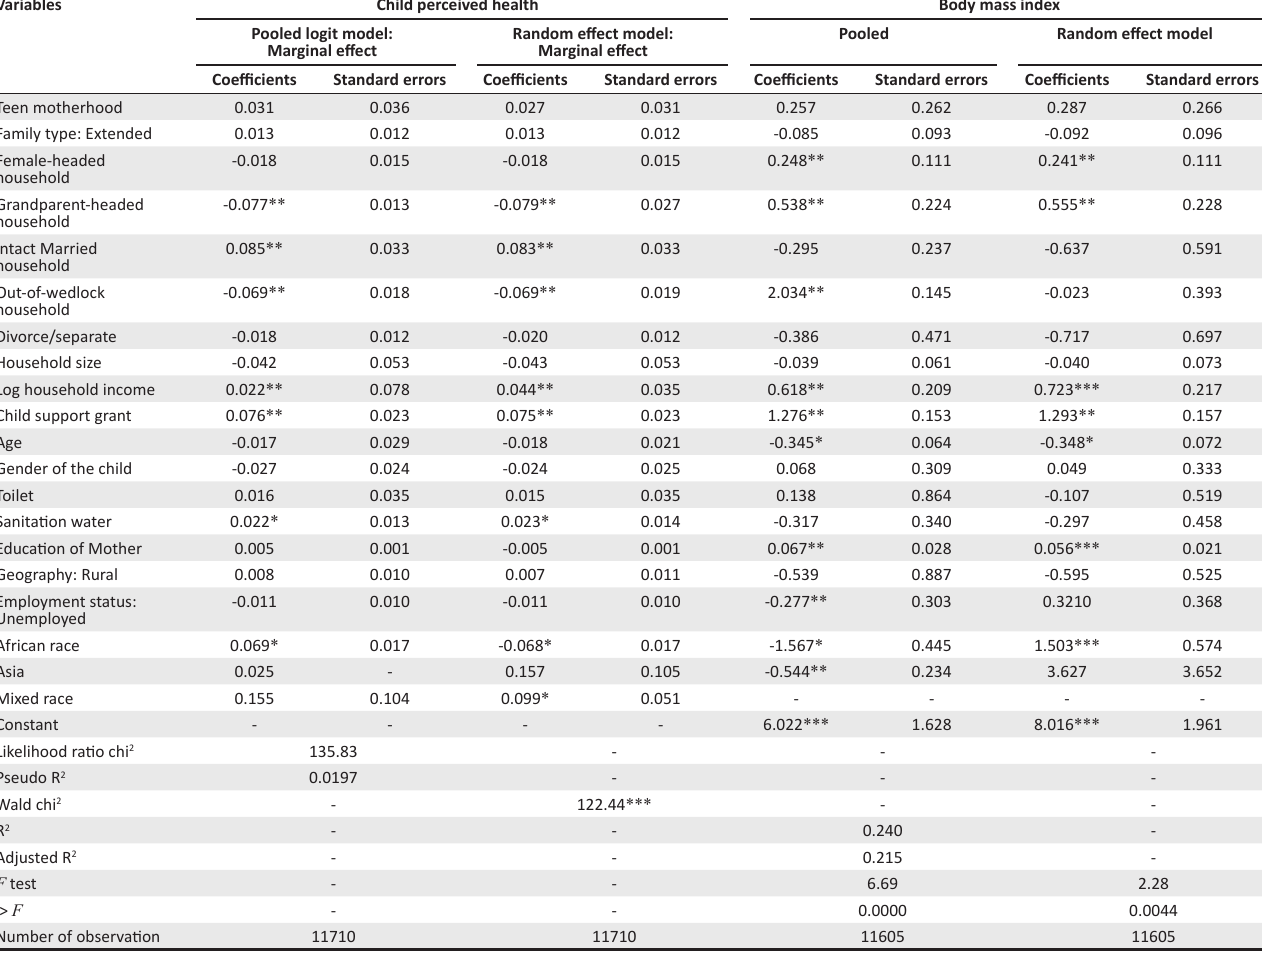
TABLE 3: Results of pooled logit and random effect model: Effects of early motherhood on child health and body mass index.